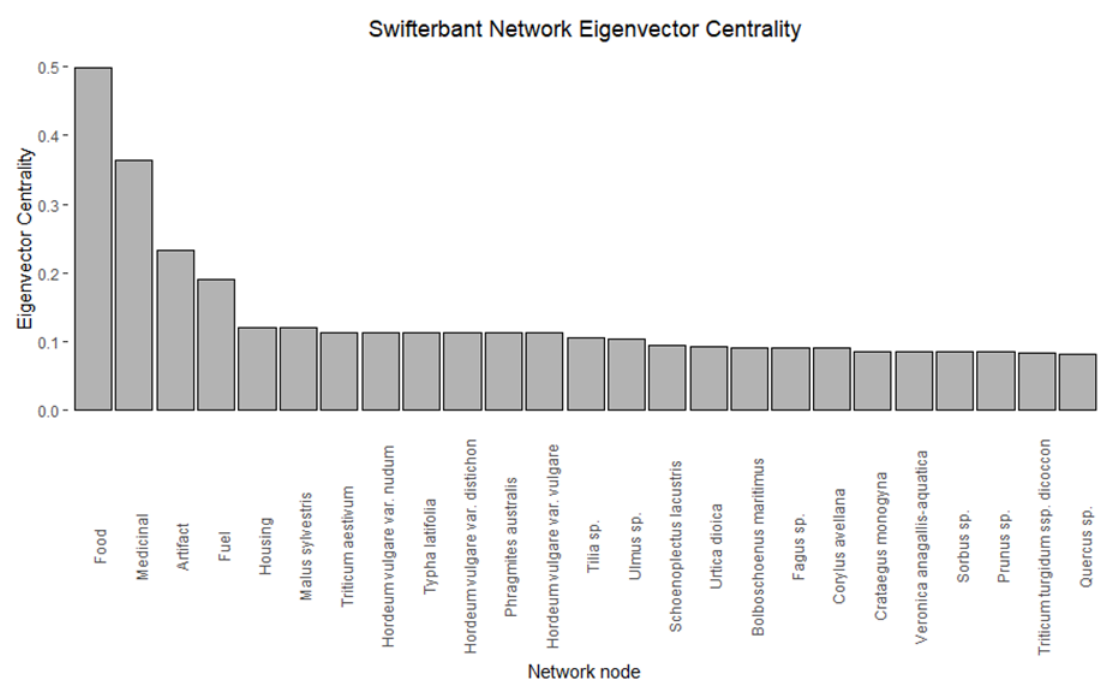
Figure 7. Network eigenvector centrality (top 25).